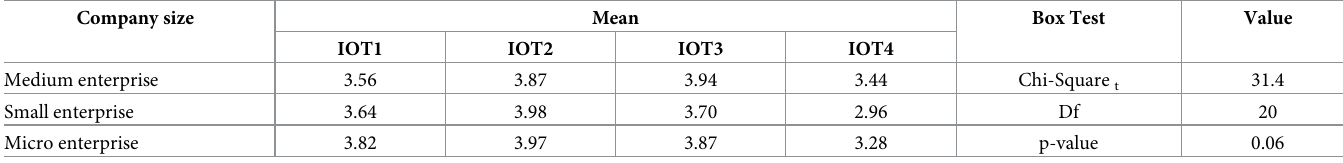
Table 12. Inter-organizational trust level and Box test. Company size